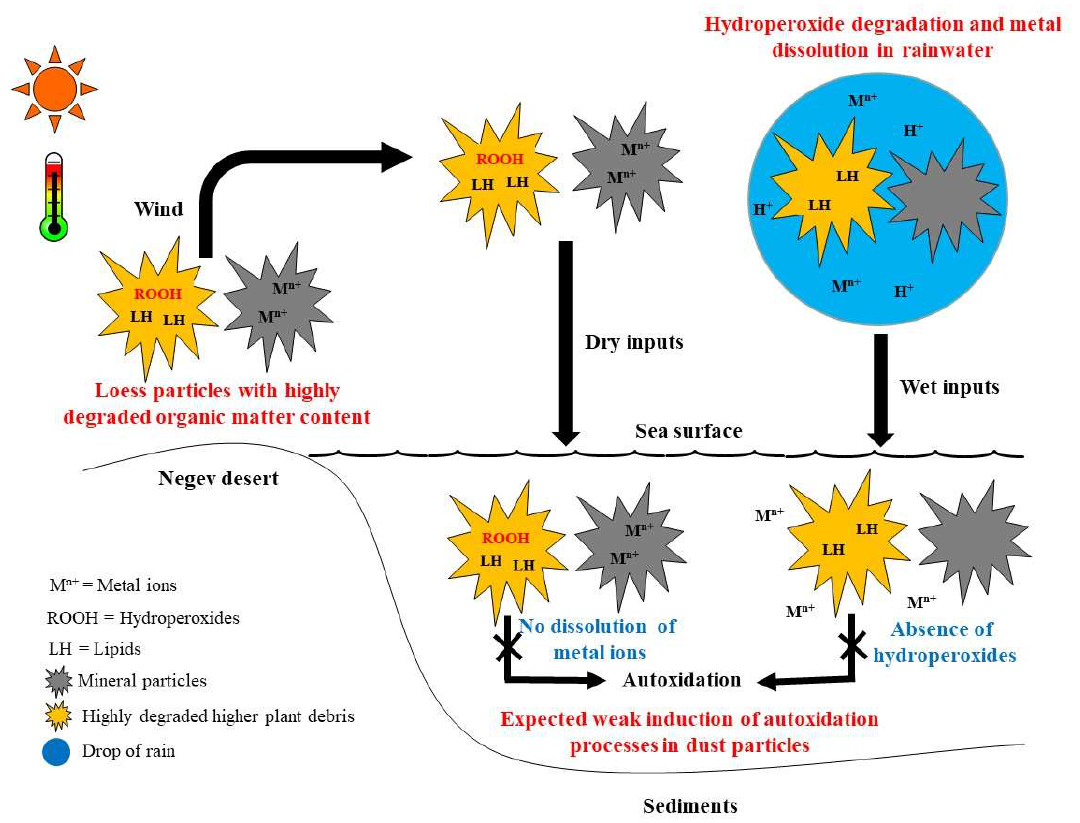
Figure 7. Conceptual scheme showing the behaviour of hydroperoxides and metal ions in dry and wet atmospheric dust inputs and in seawater.